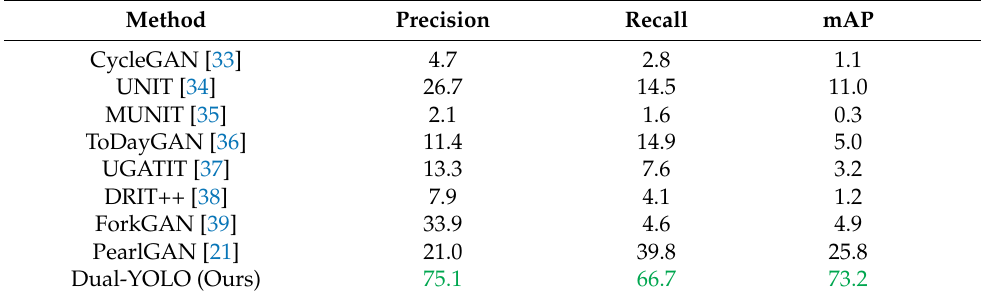
Table 5. Pedestrian detection results of the synthesized images obtained by different translation methods on the KAIST dataset computed at a single IoU of 0.5. All values are in %. The top results are marked in green.